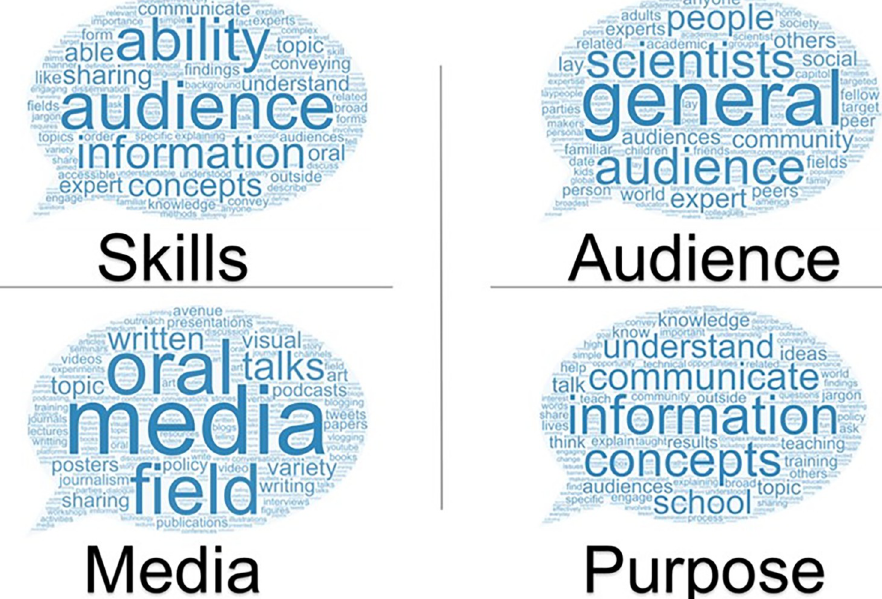
Fig 2. Word clouds highlight the complexity of participant definitions of science communication. The size of each of the words within the categorical word clouds correlates to its frequency in the coded responses. The words “science,” “scientific,” “communication,” and “communicating” have been removed in order to showcase more representative words.